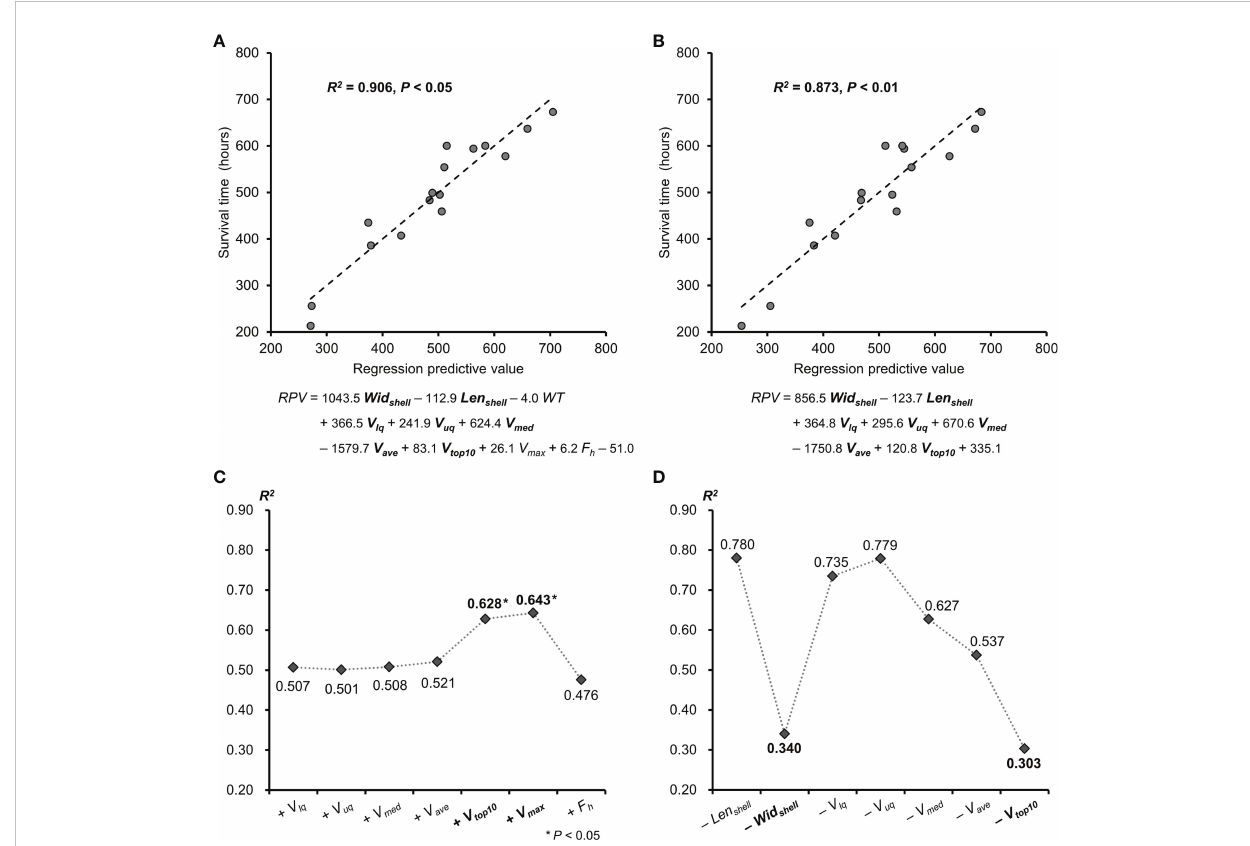
FIGURE 6 The relationship between scallop vitality predictive value and scallop survival time. (A) Signi fi cant positive correlation between scallop survival time and the RPV with the highest R 2 value. (B) Signi fi cant positive correlation between scallop survival time and the optimized RPV through backward stepwise regression. The variables involved in both equations above were shown in bold. (C) Changes of the R 2 values with the variables which were separately added to the model containing Wid shell , Len shell and WT . (D) Changes of the R 2 values with the variables which were separately removed from the model used in (B) . RPV , regression predictive value; Wid shell , shell width; Len shell , shell length; WT , whole weight; V lq , lower quartile velocity; V uq , upper quartile velocity; V med , median velocity; V ave , average velocity; V max , the maximum velocity; V top10 , average of top 10 velocities; F h , average frequency per